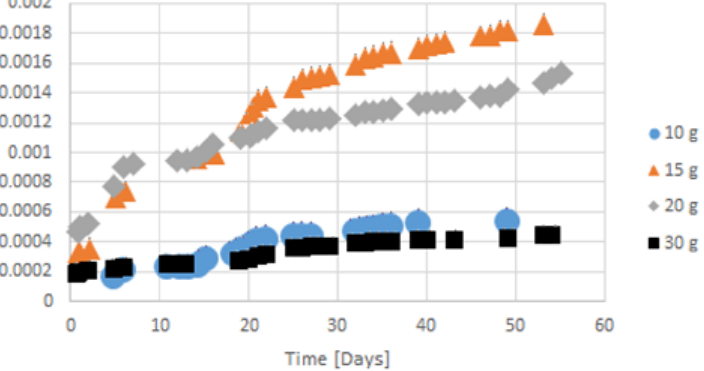
Figure 11. Accumulated hydrogen sulphide emission from gelatine in all 55 days for gelatine concentration from 10 g VSS/L to 30 g VSS/L.